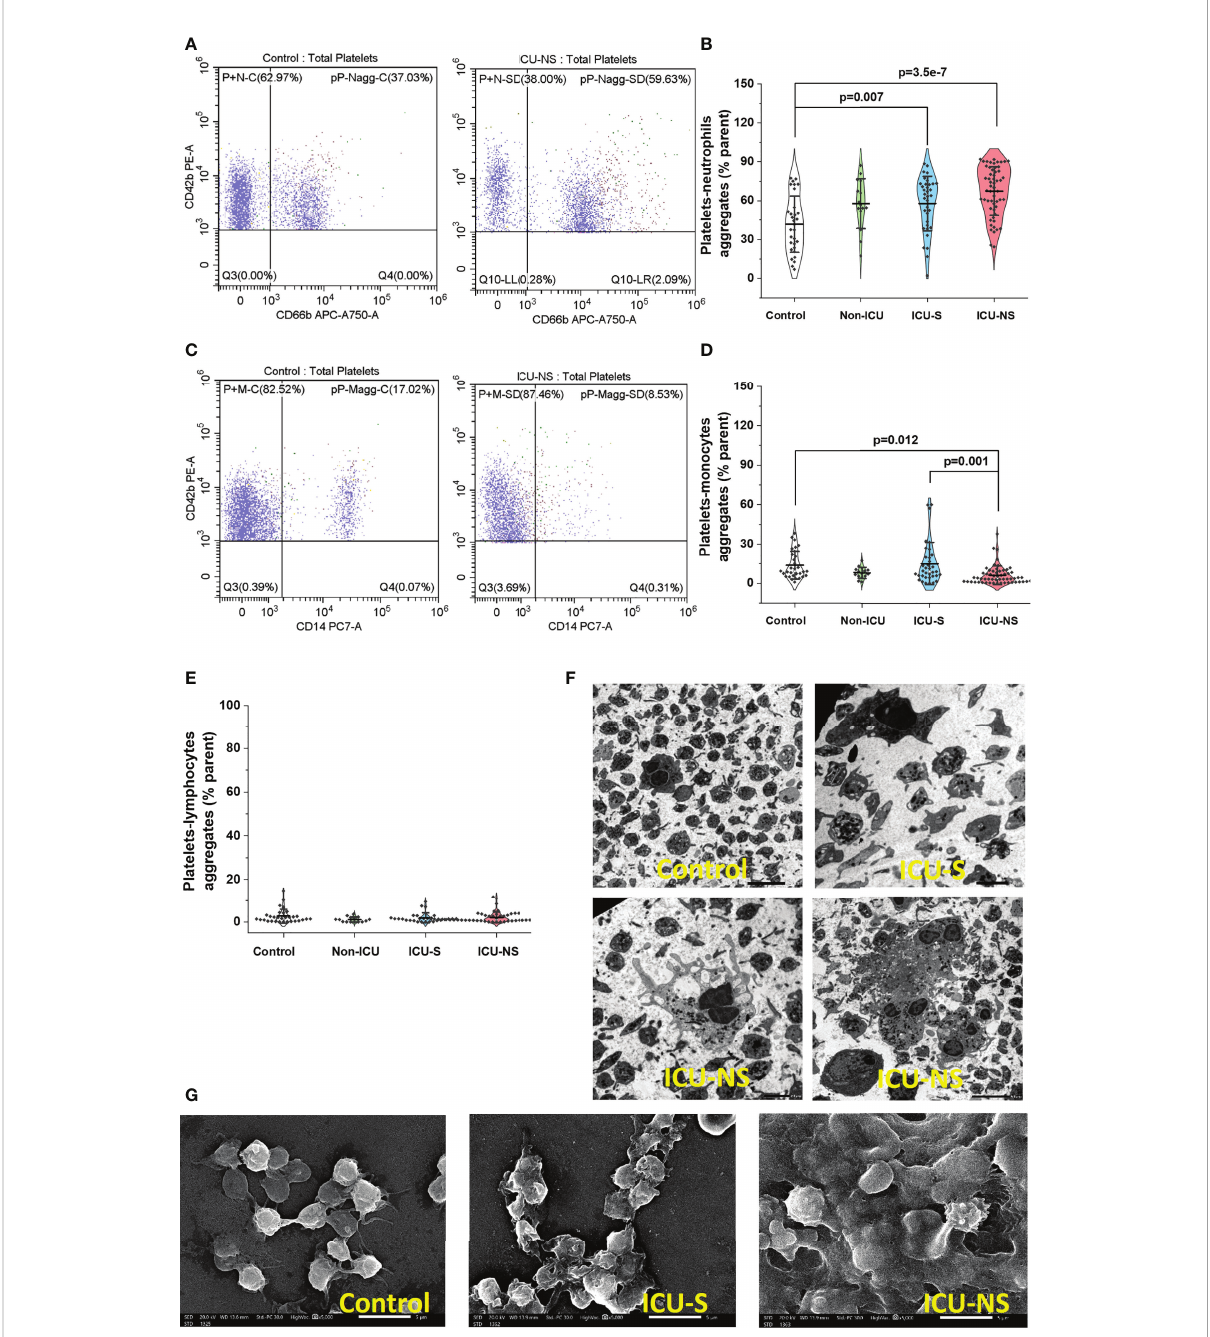
FIGURE 6 Platelet activation in severe COVID-19 patients is associated with increased tendency to aggregate with neutrophils. (A) Representative fl ow cytometric scatter plots of CD42b/CD66b double positive populations in control and ICU-NSgroups. (B) A violin plot showing signi fi cant increase in the percentage of CD42b/CD66b double positive populations in ICU patients (n=31, 15, 35, and 57 for control, non-ICU, ICU-S, ICU- NS; respectively). (C) Representative fl ow cytometric diagrams of CD42b/CD14 double positive populations in control and ICU (NS) groups. (D) A violin plot showing signi fi cant decrease in the percentage of CD42b/CD14 double positive populations in ICU-NS relative to controls, and relative to ICU-S group (n=31, 15, 35, and 57 for control, non-ICU, ICU-S, ICU-NS; respectively). (E) When the platelet-lymphocyte aggregation (CD42b/CD3 double positive populations) were compared for all groups, no statistically signi fi cant differences were observed between control, non-ICU, ICU-S, and ICU-NS (n=31, 15, 28, and 54 for control, non-ICU, ICU-S, ICU-NS; respectively). (F) Representative TEM (F) and SEM (G) images showing enhanced homo- and heterotypic aggregate formation in the ICU-NS group. Multiple comparisons were carried out using ANOVA followed by Tukey test and p values are given. Data plotted as mean ±